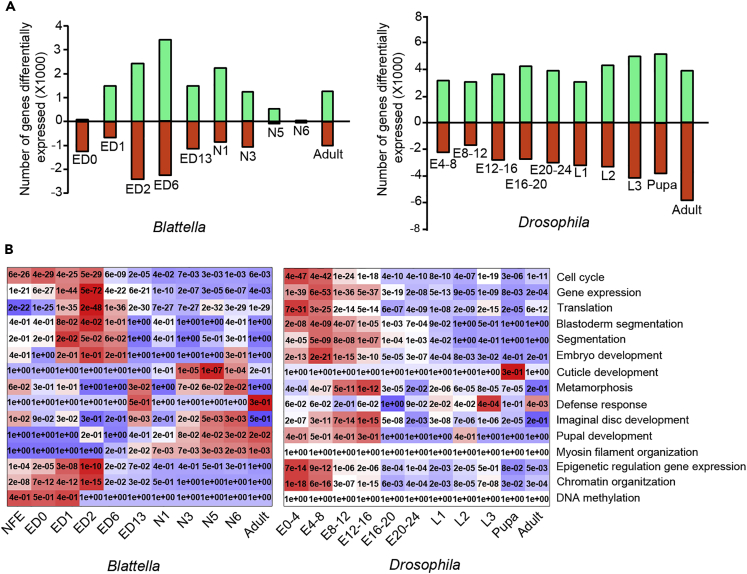
Differential Expression Analysis and GO Terms from Enrichment Analysis(A) Number of genes significantly (p < 0.05) upregulated (green) and downregulated (red) according to the differential expression analysis between consecutive stage-libraries of Blattella germanica and Drosophila melanogaster.(B) Selection of GO terms of biological processes from the enrichment analysis performed with the expressed genes at each stage in B. germanica and D. melanogaster; for each selected GO term the p value of the hypergeometric test is shown, and the color scale goes from red (low p value) to blue (high p value) normalized in each row.